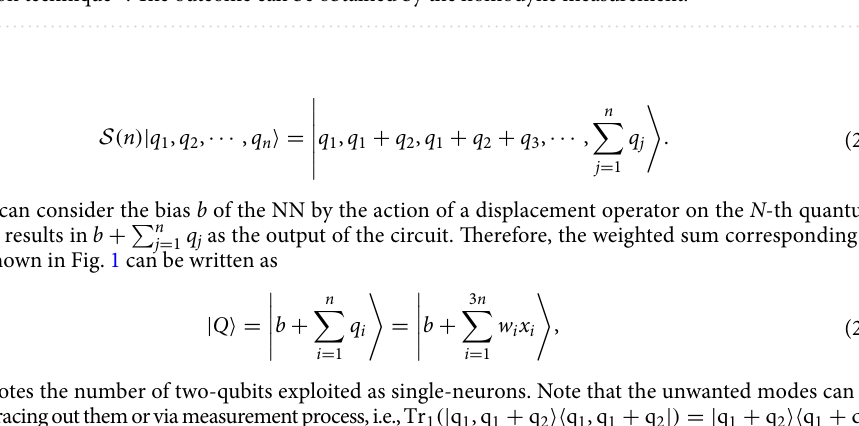
Figure 4. The pooling layer constitutes a SUM gate ( S ) analogous to the C-NOT gates for qubits but without the cyclic condition. The sum gate is a canonical two-mode gate for universal quantum computation based on continuous-variable quantum states. The continuous-variable gate can be realized with the quantum nondemolition technique 36 . The outcome can be obtained by the homodyne measurement.